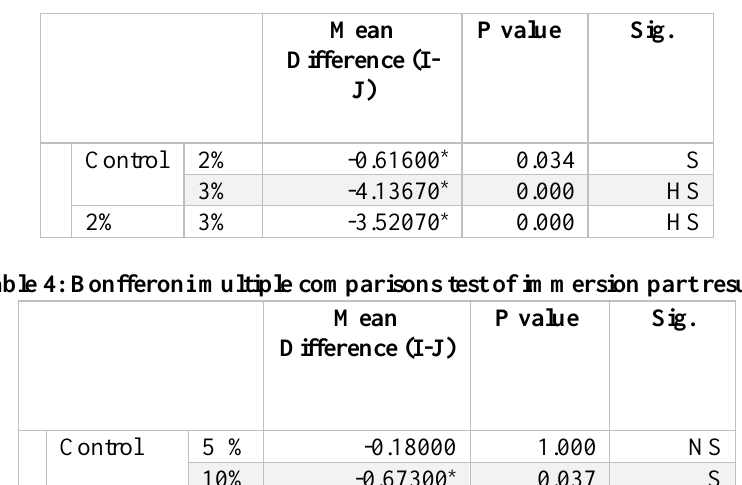
Table 3: Games Howell multiple comparisons test of incorporation part results.